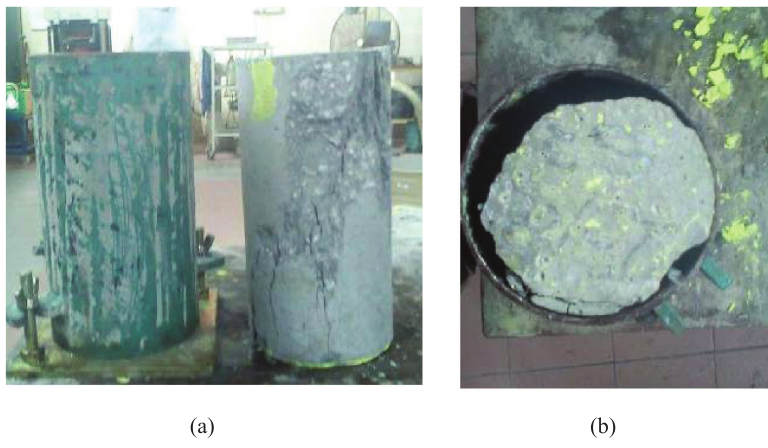
Fig. 3. Defected specimen (a); remolding of defected specimen